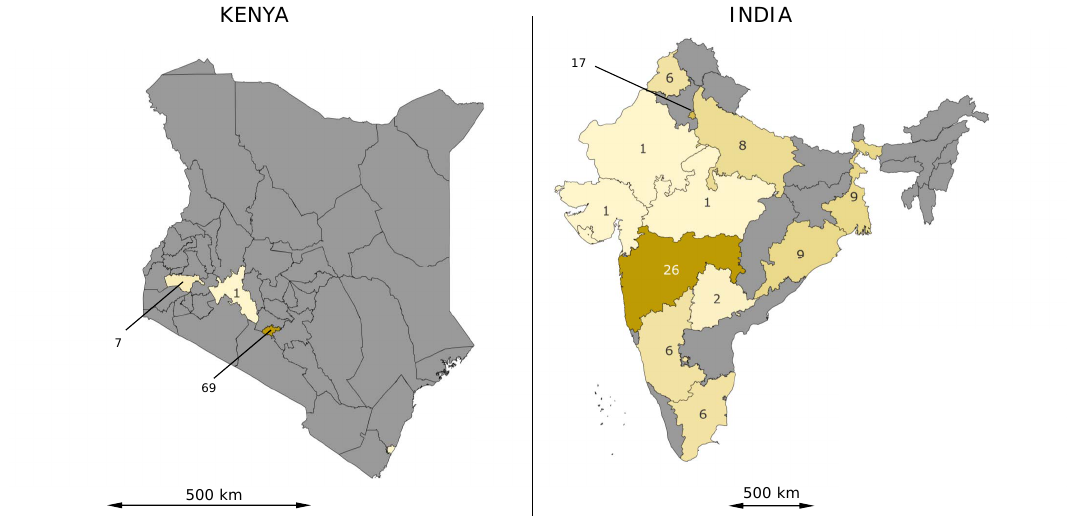
Figure 5. Number of studies on slum health in Kenya ( left ) and India ( right